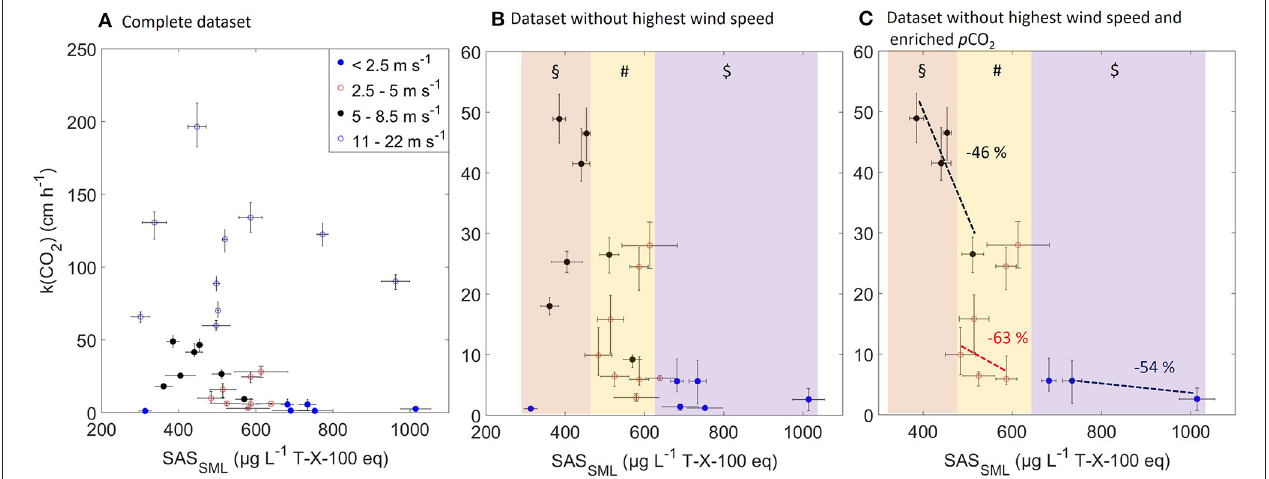
FIGURE 5 | Scatter plots of surfactant concentrations in the SML vs. gas transfer velocity k(CO2) for (A) complete data set, (B) only for wind speeds up to 10m s − 1, and (C) only under ambient pCO2 conditions and wind speeds of up 10m s − 1. The color bands in (B) and (C) show groupings of low (§), moderate (#), and high surfactant concentrations ($). The dotted lines represent the linear trend line between the highest and lowest k within each wind category, and the numbers represent the reduction in k. For the wind speed category 2.5–5m s − 1, data points with k > 20cm h − 1 were excluded when computing the trend line (see